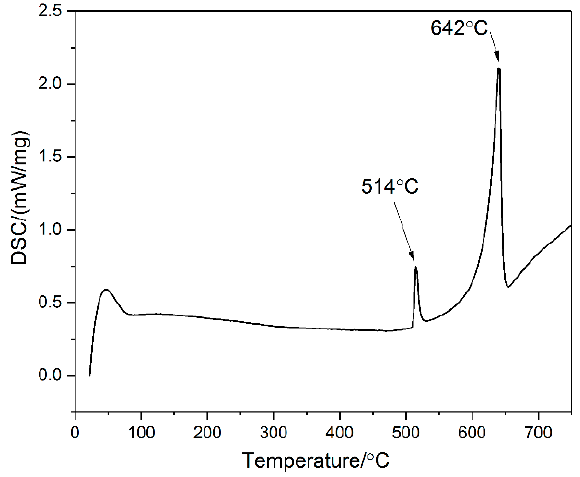
Figure 1. The differential scanning calorimetry (DSC) curve of as-cast Mg–4Sm–4Zn–0.5Zr alloy.